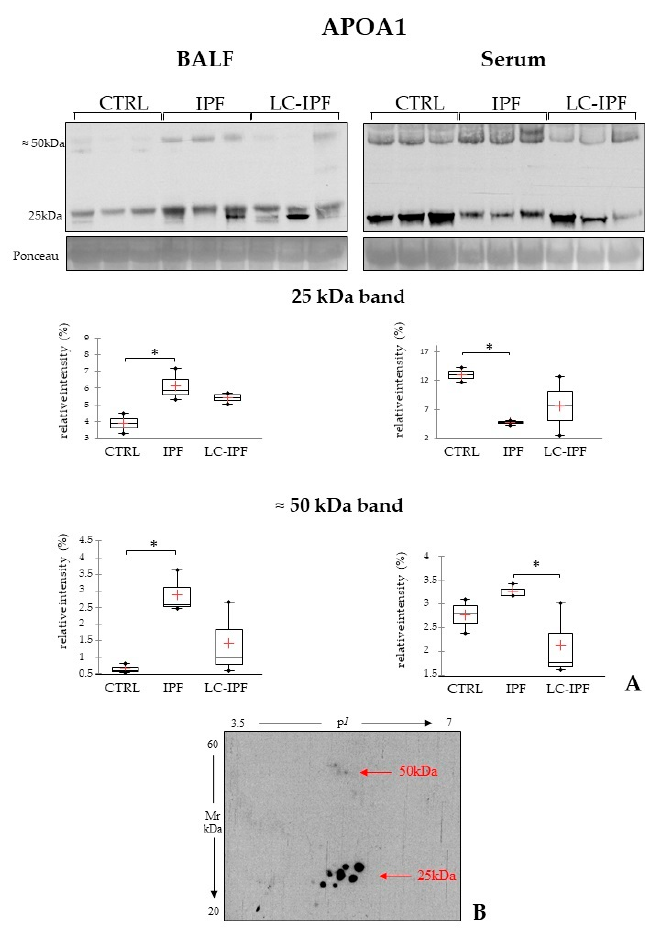
Figure 8. ( A ). Western blot analysis of APOA1 in BALF and serum samples. Statistical analysis was performed by Kruskal–Wallis test and Dunn correction and reported in the Box plots ( ∗ p -value < 0.05). Ponceau red is reported to assure the equal loaded amount of sample and for the intensity normalization. BALF and serum samples used for WB were three for CTRL, three for IPF, and three for LC-IPF. ( B ). In the bottom, the two-dimensional Western blot of APOA1 in an IPF BAL sample is reported. Classical protein species of APOA1 are highlighted at 25 kDa and other protein species at higher molecular weight (50 kDa) are also evidenced in IPF.